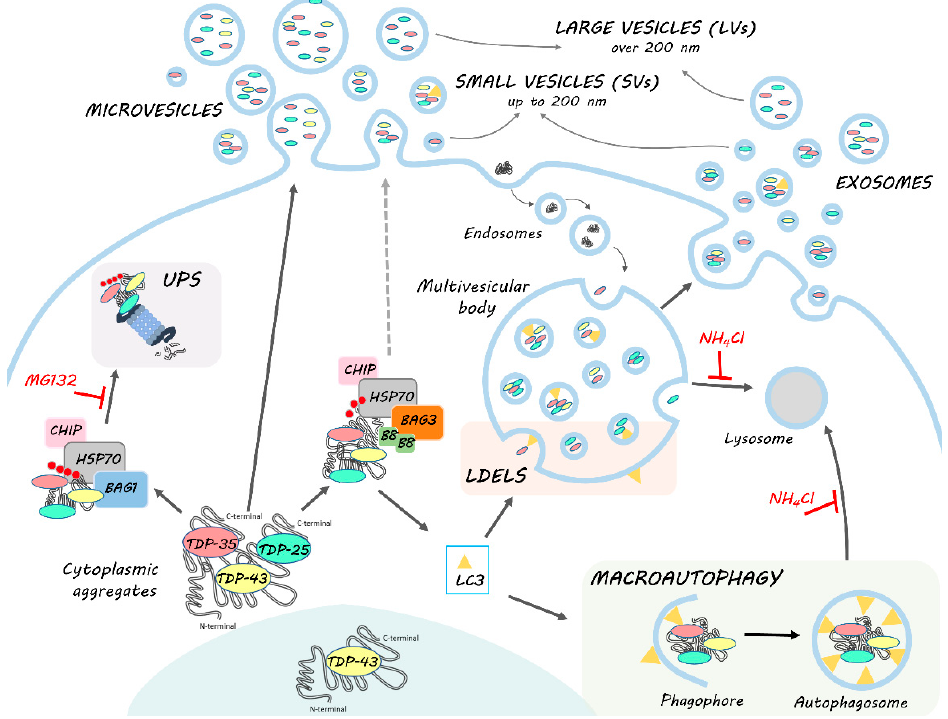
Figure 7. HSPB8-BAG3 involvement in TDP-43 proteostasis and secretion. TDP-43 is mainly localized in the nucleus. In pathological conditions, TDP-43 mislocalizes in the cytoplasm, where it accumulates together with its C-terminal fragments (TDP-35 and TDP-25) into aggregates. The clearance of TDP-43 and its C-terminal fragments occurs primarily via the UPS and autophagy, in cooperation with the PQC system. Among them, HSP70, together with CHIP, recognizes misfolded substrates (such as TDP-43 and its C-terminal fragments) and, by interacting with its co-chaperones BAG1 and BAG3, determines their disposal via UPS or autophagy, respectively. In this context, BAG3 also binds to HSPB8, forming the CASA complex, which assists in the degradation of